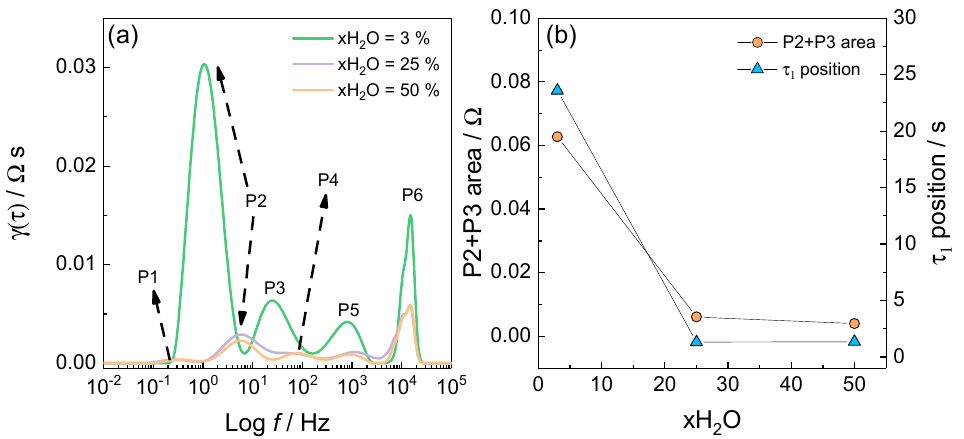
Figure 6. ( a ) DRT functions calculated from AC responses with different H 2 O content in the fuel. ( b ) P2 + P3 area and τ 1 position vs. H 2 O content in the fuel. T = 750 °C, j = OCV, Q FE = 50 mL min − 1 , Q AE = 50 mL min − 1 , and xO 2 = 21%.